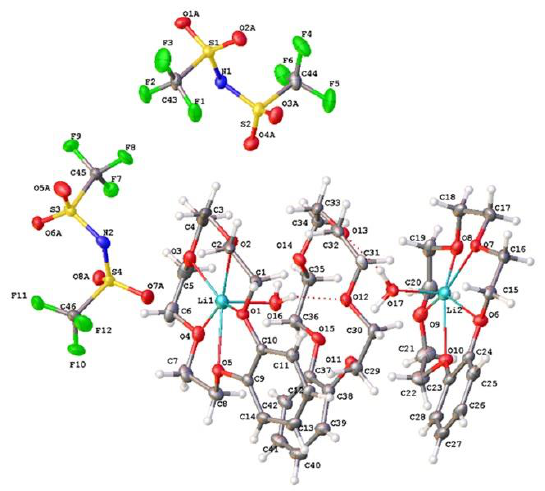
Figure 8. Structure of formula units of crystal ( II mon ). Ellipsoids of atomic l.s. thermal displacements are given at the 50% probability level.